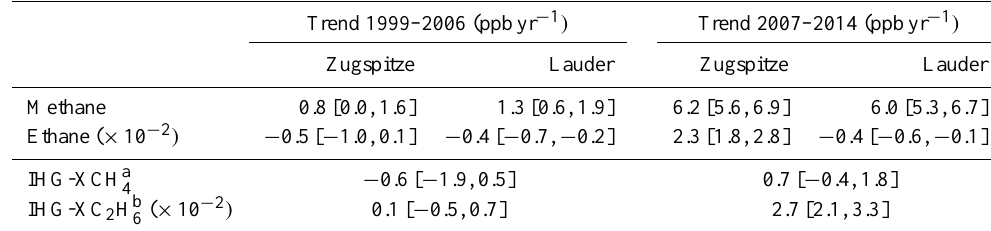
Figure 1. Time series of monthly mean column-averaged dry-air mole fractions of (a) methane and (b) ethane measured at Zugspitze and √ n with monthly means calculated from n individual measurements with Lauder. Error bars indicate statistical standard error of ± 3 σ/ standard deviation σ . Deseasonalized time series for (c) methane and (d) ethane are displayed along with linear trend estimates (black lines). See Table 1 for trend magnitudes and uncertainties. Table 1. Results of trend analysis: linear trend estimates and 95% confidence